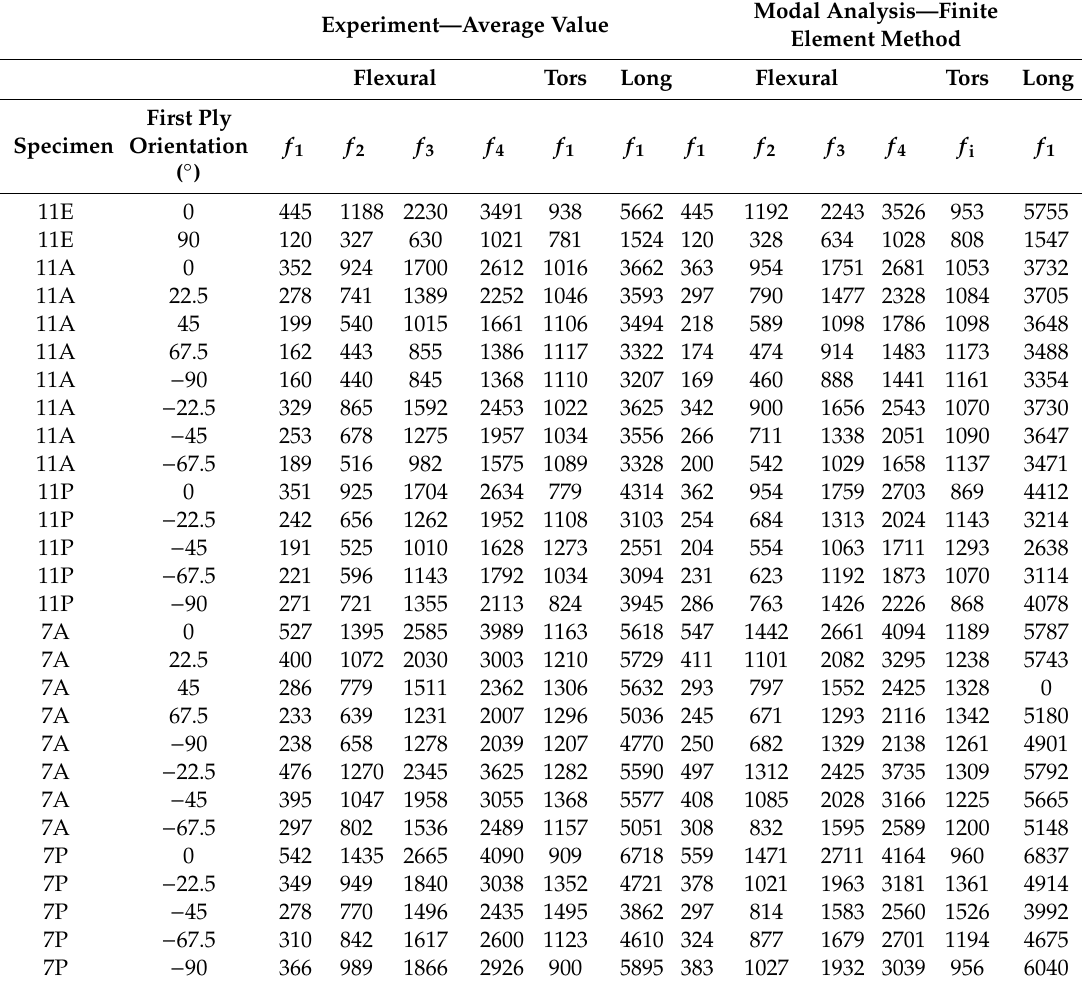
Table 4. Average measured and calculated natural frequencies, using finite element modal